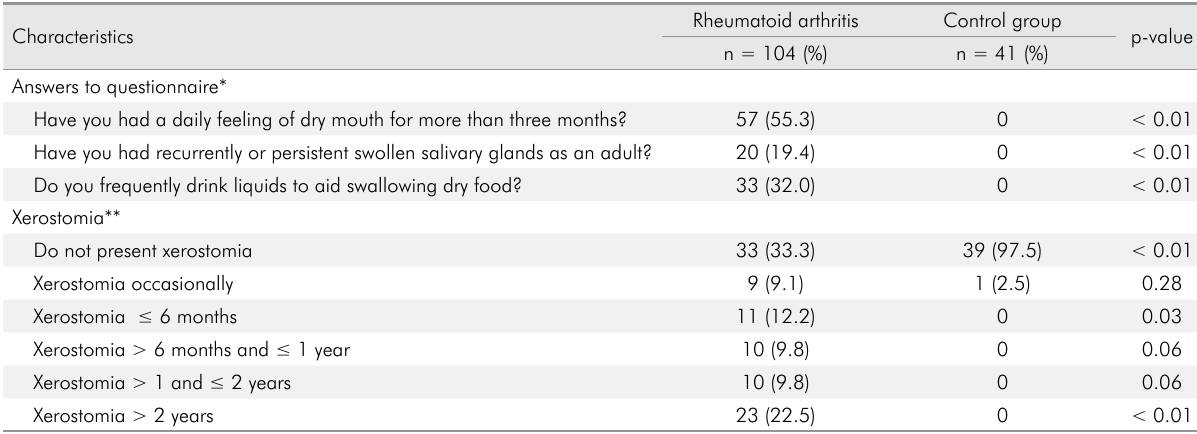
Table 2. Symptoms related to salivary function of the 145 studied subjects.